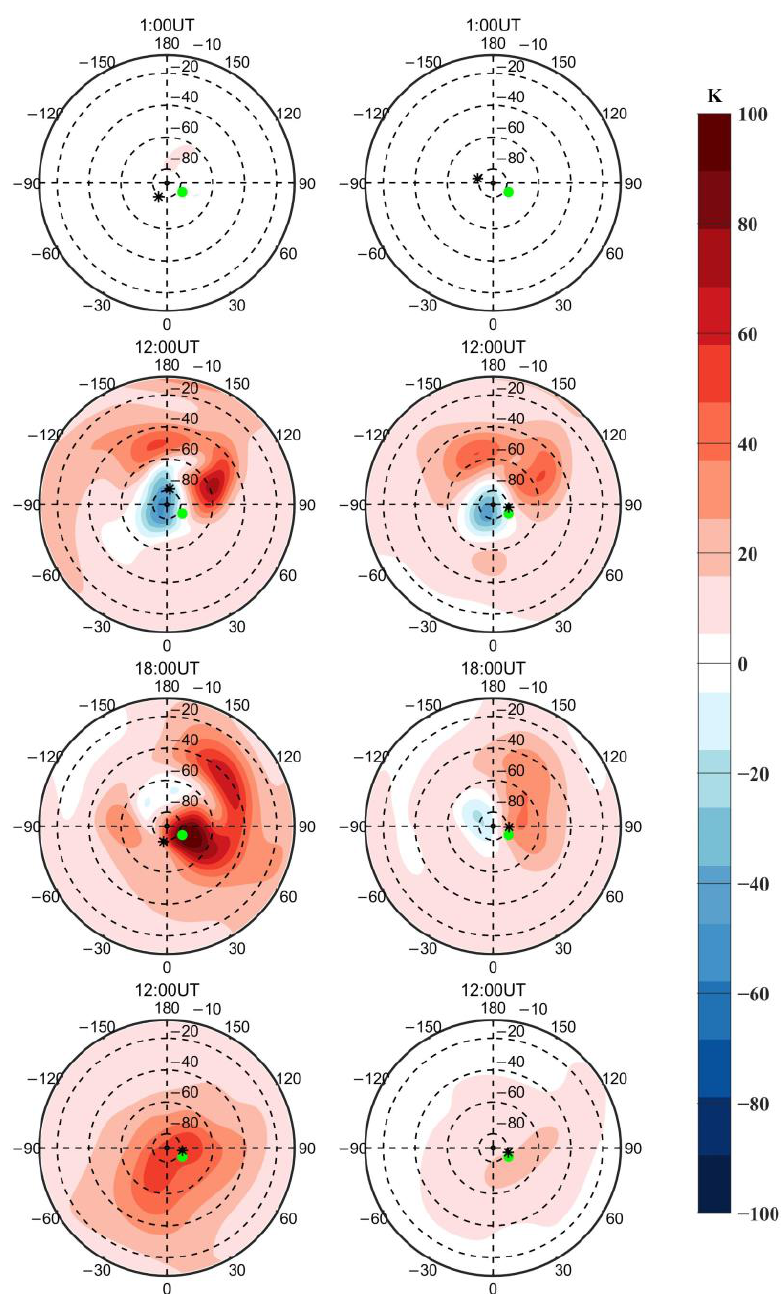
Figure 2. The first three rows correspond to the temperature difference (rkp − ckp) for TIMEGCM simulations at 01:00 UT (first row), 12:00 UT (second row), and 18:00 UT (third row) on the first day of the storm (20 April 2018 on the left column and 10 April 2022 on the right column) at 110 km in the southern hemisphere. The fourth row is the same as the first three rows but at 12:00 UT on the second day of the storm (21 April 2018 on the left column and 11 April 2022 on the right column). The black asterisks mark the locations of the satellite observation points at the corresponding time. The green dots mark the position of (78.75 ◦ S, 60 ◦ E), which is used for the subsequent thermodynamic diagnostic analysis.